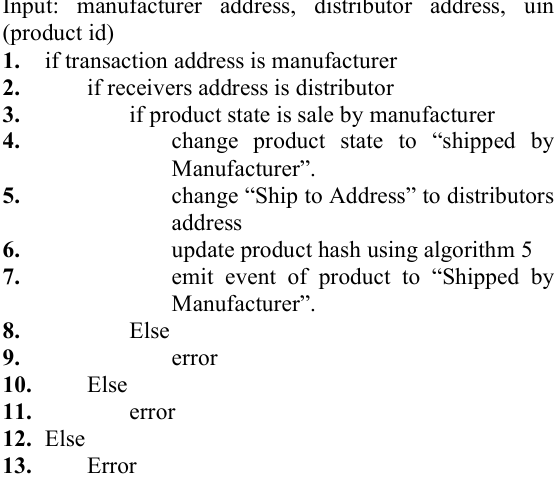
Algorithm 5: Generate Product Hash using Keccak